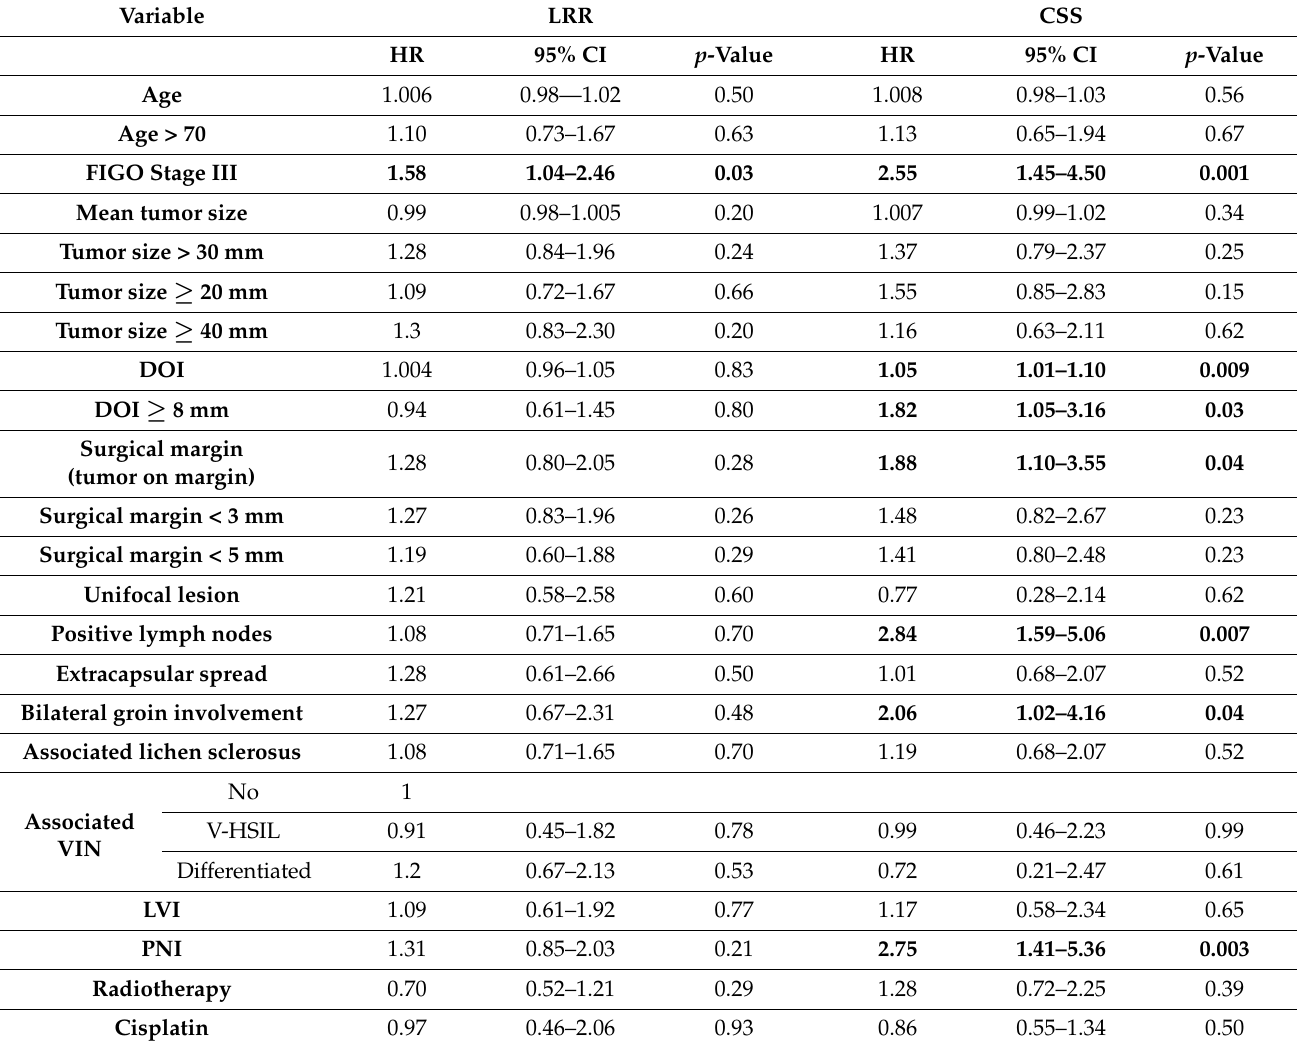
Table 3. Univariate analysis of factors associated with locoregional recurrence (LRR) and cancer- specific survival (CSS) (statistically significant factors are highlighted in bold).